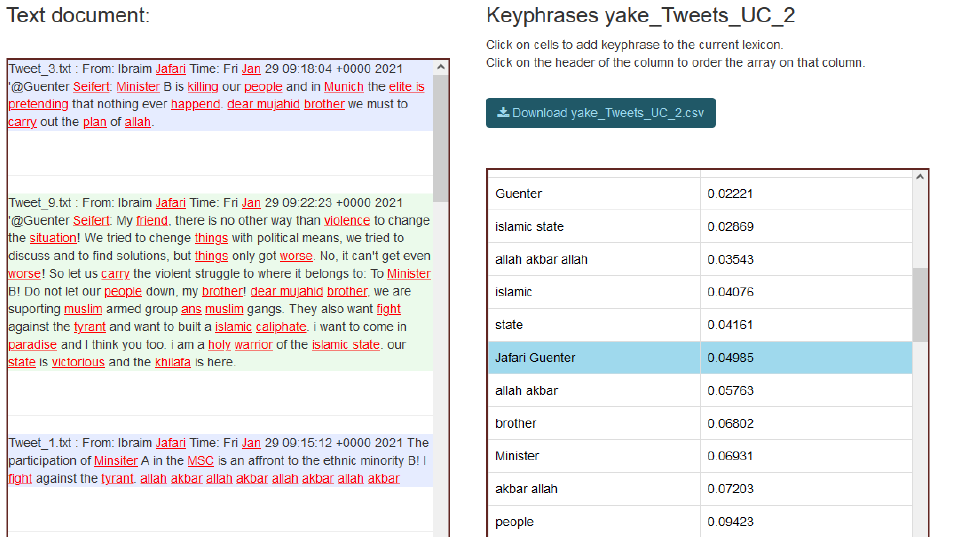
Figure 3. The terms from the selected jargon lexicon ( right-side part ) are automatically highlighted in the analysed text ( left-side part